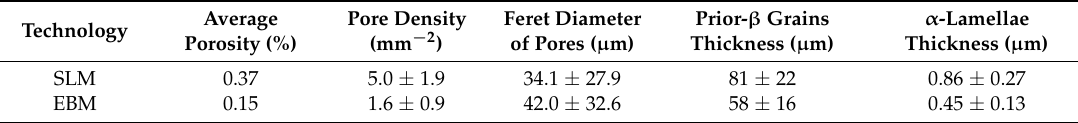
Figure 3. Micrographs showing a fine two-phase lamellar morphology and elongated grains (parallel to the building direction) of Ti6Al4V manufactured by SLM ( a , c ) and EBM ( b , d ). Table 1. Microstructural features compared for SLM and EBM